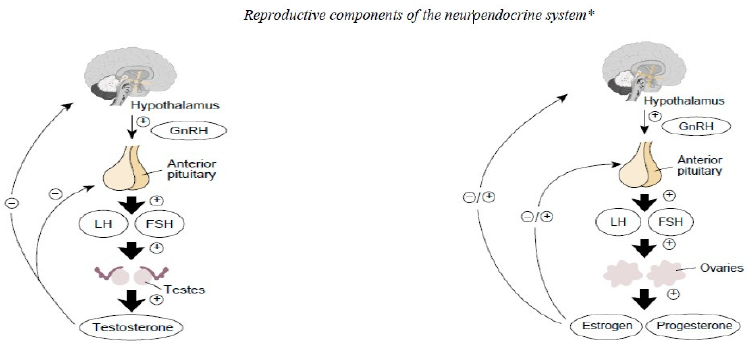
Figure 2. male and female hypothalamic-pituitary-gonadal axes.